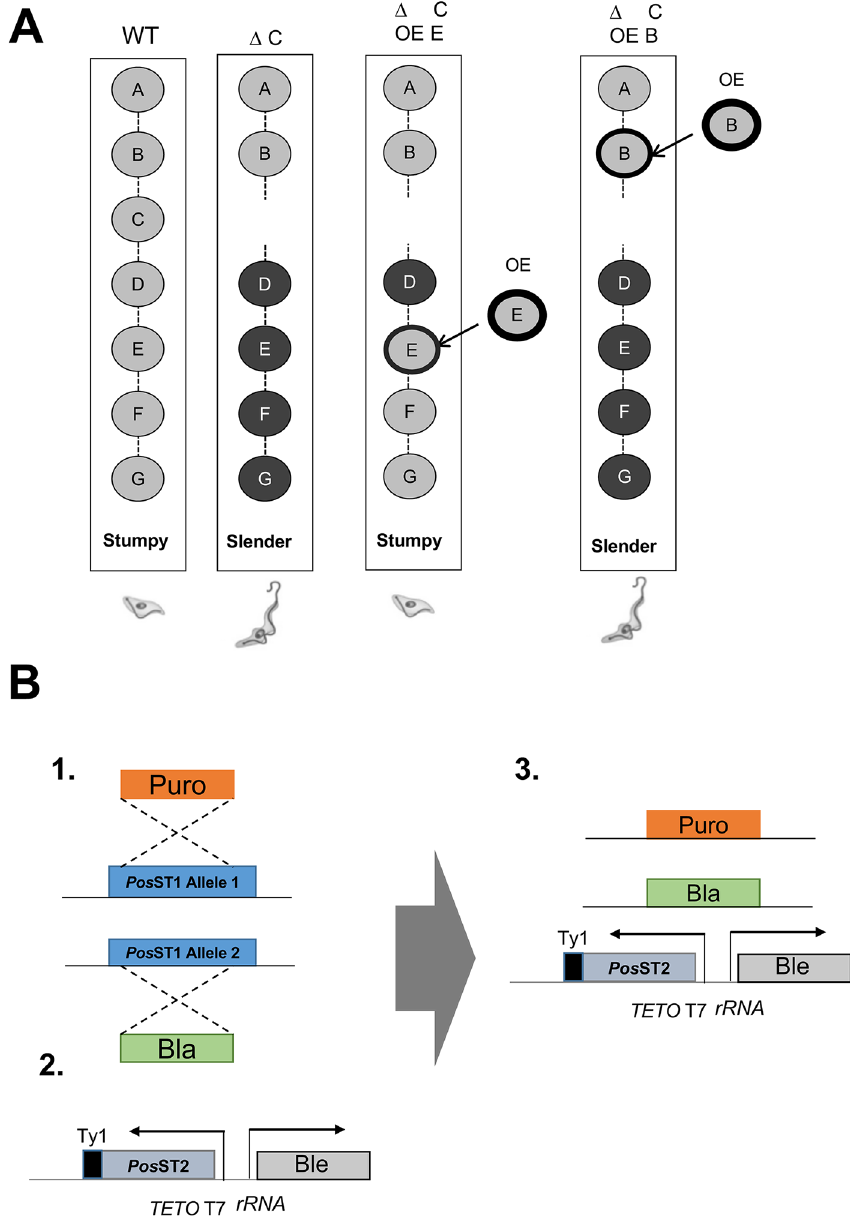
Fig 1. Schematic representation of the experimental approach. A. linear signal transduction pathway is represented which, when activated, signals slender forms to differentiate into stumpy forms. If a pathway component is removed (e.g. component C), then stumpy formation is prevented and the parasites remain slender. However, if a component downstream is overexpressed (‘OE’), or a constitutively active mutant expressed, the pathway function can be restored, and stumpy formation occurs. If the overexpressed pathway component is upstream of the breakpoint, the parasites remain slender. B. Strategy for the creation of cell lines to test extragenic suppression in the SIF signalling pathway. For creating null mutants, sequential allelic deletion (step 1) used antibiotic resistance cassettes targeting a given PosST (Positive regulator of STumpy formation) gene in the T . brucei EATRO 1125 AnTat1.1 90:13 parental line, that is capable of tetracycline inducible gene expression. Ectopic expression in the resulting null mutant of a further PosST gene, modified by incorporation of the Ty1 epitope tag sequence was achieved under tetracyclic-inducible regulation (steps 2,3) via the tetracycline/doxycycline regulated T7 promoter (‘TETO T7’).